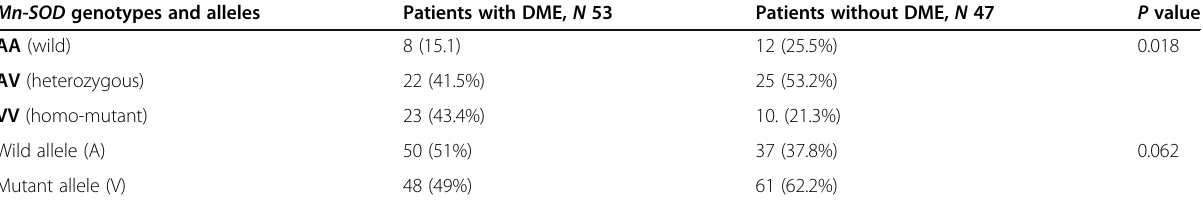
Table 2 Frequency distribution of different genotypes and alleles in DME and non-DME groups Mn-SOD genotypes and alleles Patients with DME, N 53